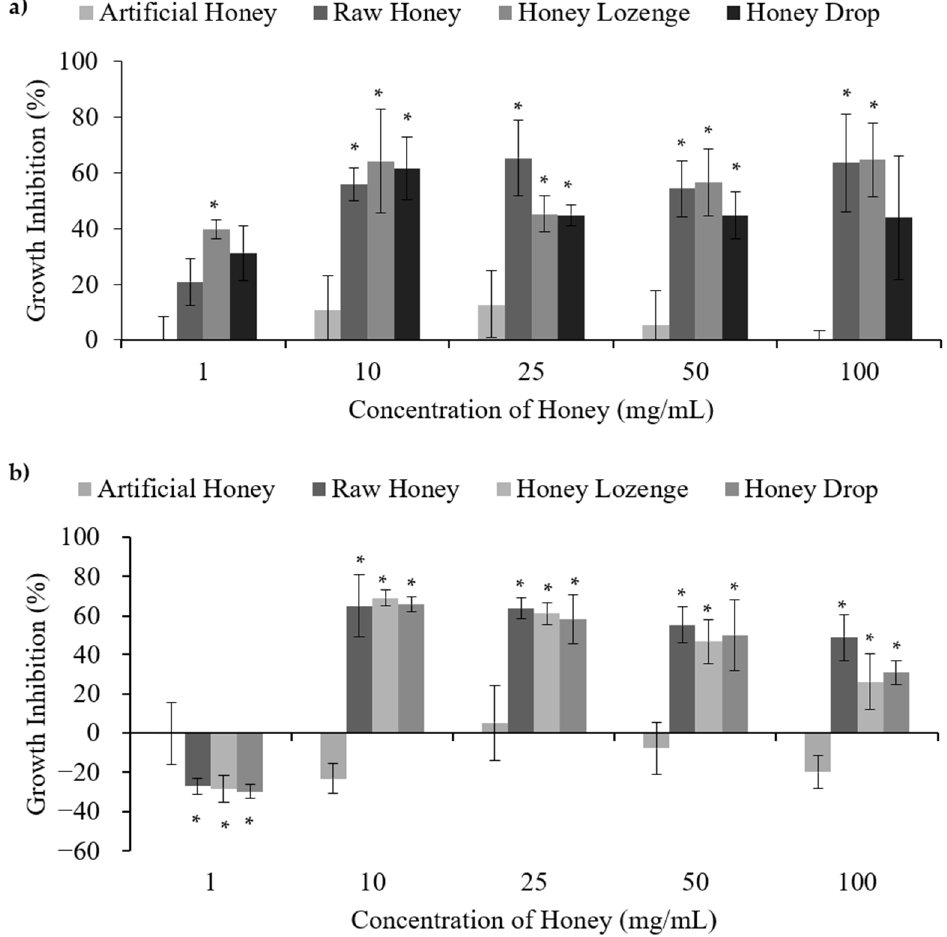
Figure 2. Antibacterial activities of honey with ( a ) E. coli and ( b ) M. luteus , upon treatment with different concentrations of raw and processed honey samples. Artificial honey is included as a control for the sugar content of honey. * Indicates significant difference from the negative